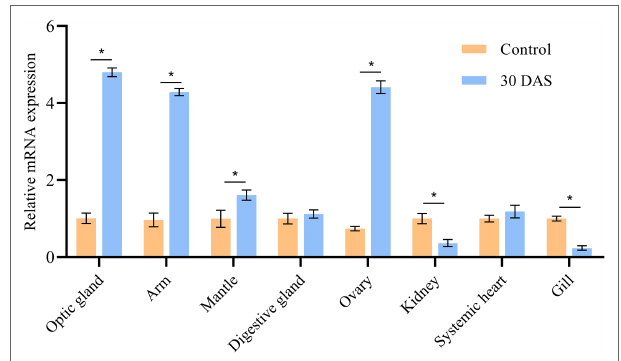
FIGURE 3 | Expression profile of ImpL 2 in optic gland in the control, starvation and senescence group. Data were normalized to the abundance of EF expressed in the same samples and are presented as the mean ± SD (n = 3). Groups with different letters are significantly different from each other (p<0.05, ANOVA followed by LSD test). DAF, days after fasting; DAS, days after spawning.